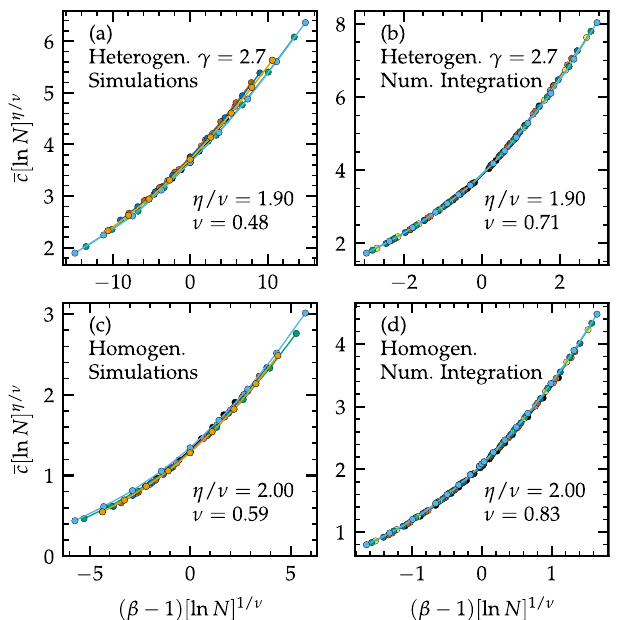
Fig. 5 Finite size scaling analysis. Data collapse of the average local clustering coef fi cient at different sizes as de fi ned in Eq. (13) for heterogeneous networks with γ = 2.7 (panels ( a ) and ( b )) and homogeneous networks (panels ( c ), and ( d )). The panels ( a ) and ( c ) correspond to numerical simulations with sizes in the range N ∈ (5 × 10 2 , 10 5 ), whereas the panels ( b ) and ( d ) are obtained from numerical integration of Eq. (8) with sizes in the range N ∈ (5 × 10 5 , 10 8 ). Different colors correspond to the different system sizes used. Error bars representing the standard error are smaller than the data points and therefore not